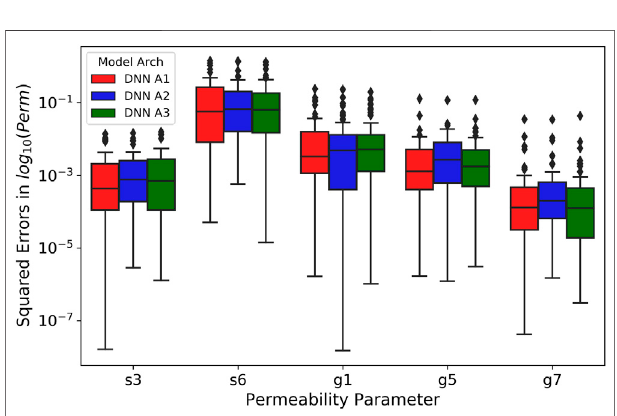
FIGURE6| Boxplot ofthesquarederroroftheDNNson thetesting set. The x -axis is the permeability parameter. The y -axis is the squared error of the estimated log 10 of the permeability parameter compared to their true values. The y -axis is plotted in log-scale for showing differences spanning over several orders of magnitude. The results for different DNN architectures are represented by the colors fi lling the box plots.